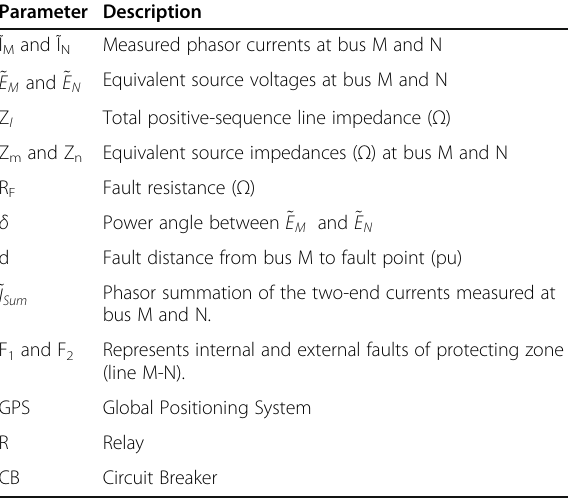
Table 1 List of symbols used in Fig. 1 Parameter Description